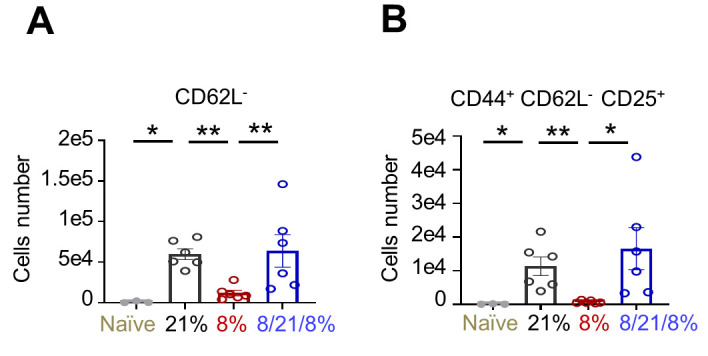
Short oxygen exposure rescues CD8+ T cells activated under hypoxia in vivo.C57BL6 mice were primed intradermally in the ear pinna with 5 × 106 TU of Lv-OVA or left uninfected. Twenty-four hours after the viral challenge, mice were divided into four groups: (1) Lv-OVA infected mice grown in 21% O2 (21%). (2) Lv-OVA infected mice grown in 8% O2 (8%). (3) Lv-OVA infected mice grown in 8% O2 for 48 hr, transferred to 21% O2 for 24 hr and then transferred back 21% O2 for another 48 hr (8/21/8%). (4) Lv-OVA uninfected mice grown in 21% O2 (Ctrl). Seven days from the beginning of the experiment, cells from the deep cervical lymph nodes were analyzed by flow cytometric analysis. (Naïve n = 3 biological replicates, activated n = 6 biological replicates per group) (A) Bar graph summarizes the number of TCR Vα2+, CD8+ and CD62L- cells in each of the groups. (P value * 0.0238 ** 0.0022 ** 0.0087) (B) Bar graph summarizes the number of TCR Vα2+, CD8+, CD44+, CD25+ and CD62L- cells in each of the groups. (P value * 0.0238 ** 0.0022 * 0.0299). Statistical method, non-parametric Mann-Whitney test, mean ± s.e.m.